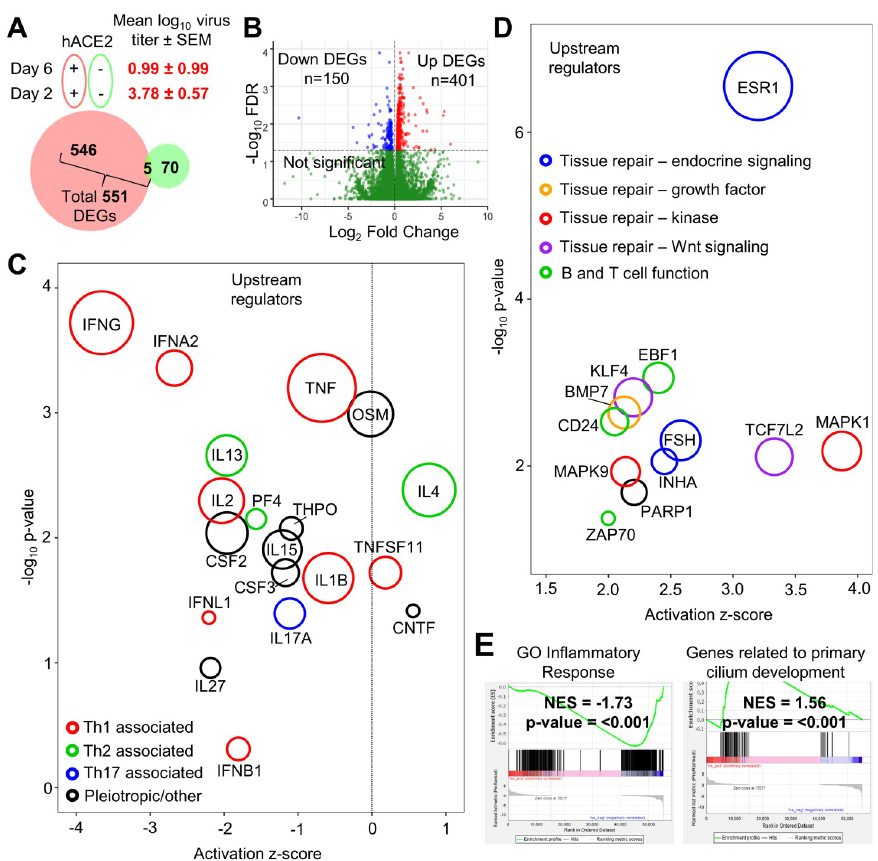
Fig 5. Day 6 post-infection is characterized by inflammation resolution and tissue repair signatures. A) Venn diagram for DEGs comparing day 6 versus 2 post infection with (red) and without (green) hACE2-lentivirus transduction. Number of DEGs that are FDR < 0.05 are shown. Mean virus titer (log 10 CCID 50 /g) in lung tissue ± SEM (represents data shown in Fig 2D) is shown for hACE2 transduced mice at day 2 or 6 post infection. B) Volcano plot of gene expression from RNA-seq analyses of hACE2-lentivirus transduced lung RNA comparing day 6 with day 2 (see S2B and S2C Dataset for gene and DEG lists). Genes were considered DEGs if they had a FDR value < 0.05 (above horizontal dotted line). C) Cytokine signatures identified by IPA USR analysis (see S2D and S2E Dataset for full and cytokine only lists) of 551 DEGs identified in ‘B’ (S2C Dataset). Circle area reflects the number of DEGs associated with each USR annotation. USRs were grouped into four categories; red = Th1 associated, green = Th2 associated, blue = Th17 associated, and black = pleiotropic/other. The vertical dotted line indicates activation z-score of 0. D) Upregulated USR signatures identified using IPA analysis (see S2F Dataset) of 551 DEGs identified in ‘B’. Circle area reflects the number of DEGs associated with each USR annotation. USRs (excluding chemicals) with an activation z- score of > 2 are shown and were grouped into five categories; green = B and T cell function, blue = tissue repair– endocrine signaling, orange = tissue repair–growth factor, red = tissue repair–kinase, purple = tissue repair–Wnt signaling. E) Selected plots from GSEA of entire MSigDB database using pre-ranked (by fold change) ‘all’ gene list (S2B Dataset). NES score and p-value is shown for the “GO_inflammatory_response”